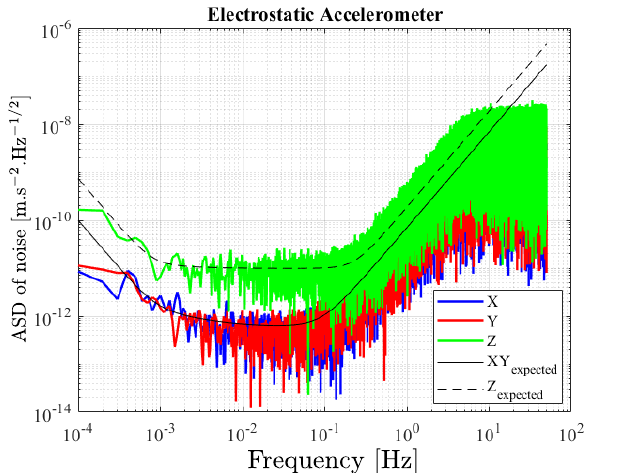
Figure 21. ASD of noise for the EA HybridSTAR given for the three axis in case of a non-rotating